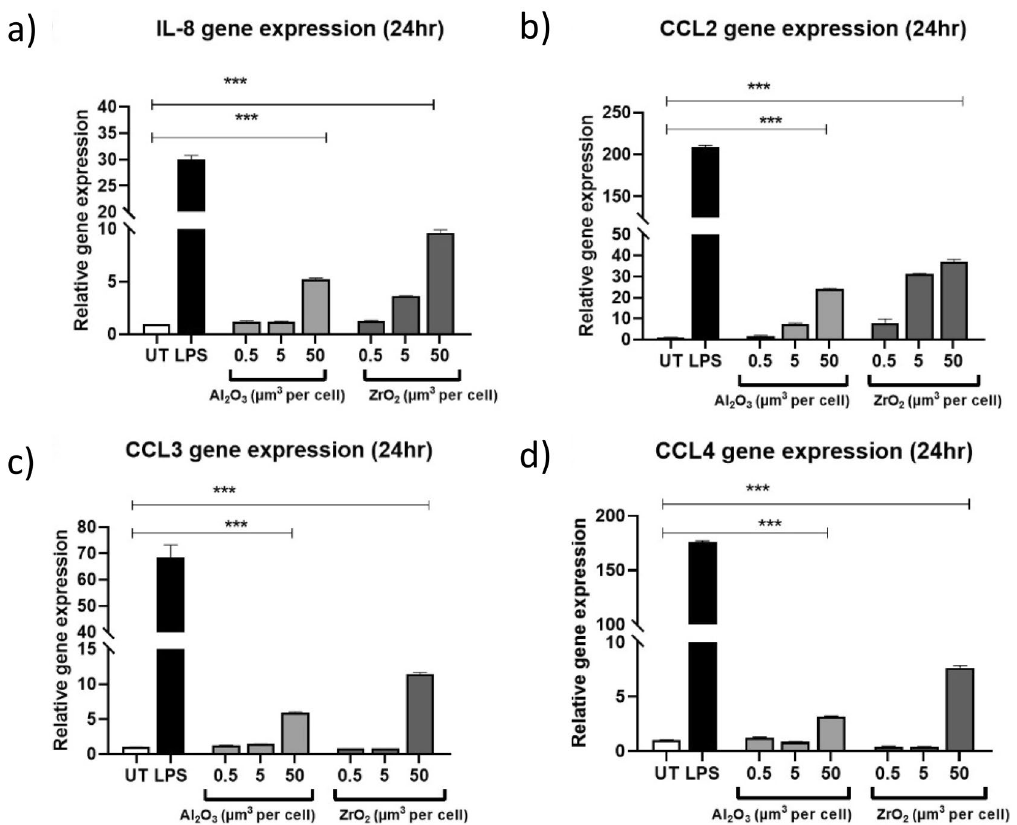
Figure 3. THP-1 macrophage relative gene expression following treatment with Al 2 O 3 or ZrO 2 . THP-1 macrophages activated using PMA and treated with Al 2 O 3 or ZrO 2 (0.5–50 µm 3 particles per cell) for 24 h. Relative gene expression was assessed using RT-qPCR. All experiments included an untreated negative control and LPS-treated (10 ng/mL) THP-1 macrophages as a positive control. ( a ) At the highest dosages of both ceramic metal oxide nanopowders there was a significant increase in the relative gene expression of IL-8 when compared to untreated controls (Al 2 O 3 P < 0.0001 and ZrO 2 P < 0.0001). ( b ) CCL2 relative gene expression increased significantly following treatment with 50 µm 3 particles per cell Al 2 O 3 (P < 0.0001) and ZrO 2 (P < 0.0001) when compared to an untreated negative control. ( c ) There was significant increases in CCL3 relative gene expression following treatment of THP-1 macrophages with 50 µm 3 per cell Al 2 O 3 (P < 0.0001) and ZrO 2 (P < 0.0001). ( d ) THP-1 macrophages treated with 50 µm 3 per cell Al 2 O 3 or ZrO 2 experienced significant increases in CCL4 relative gene expression compared to an untreated control (Al 2 O 3 P < 0.0001 and ZrO 2 P < 0.0001). All data presented is representative of n =